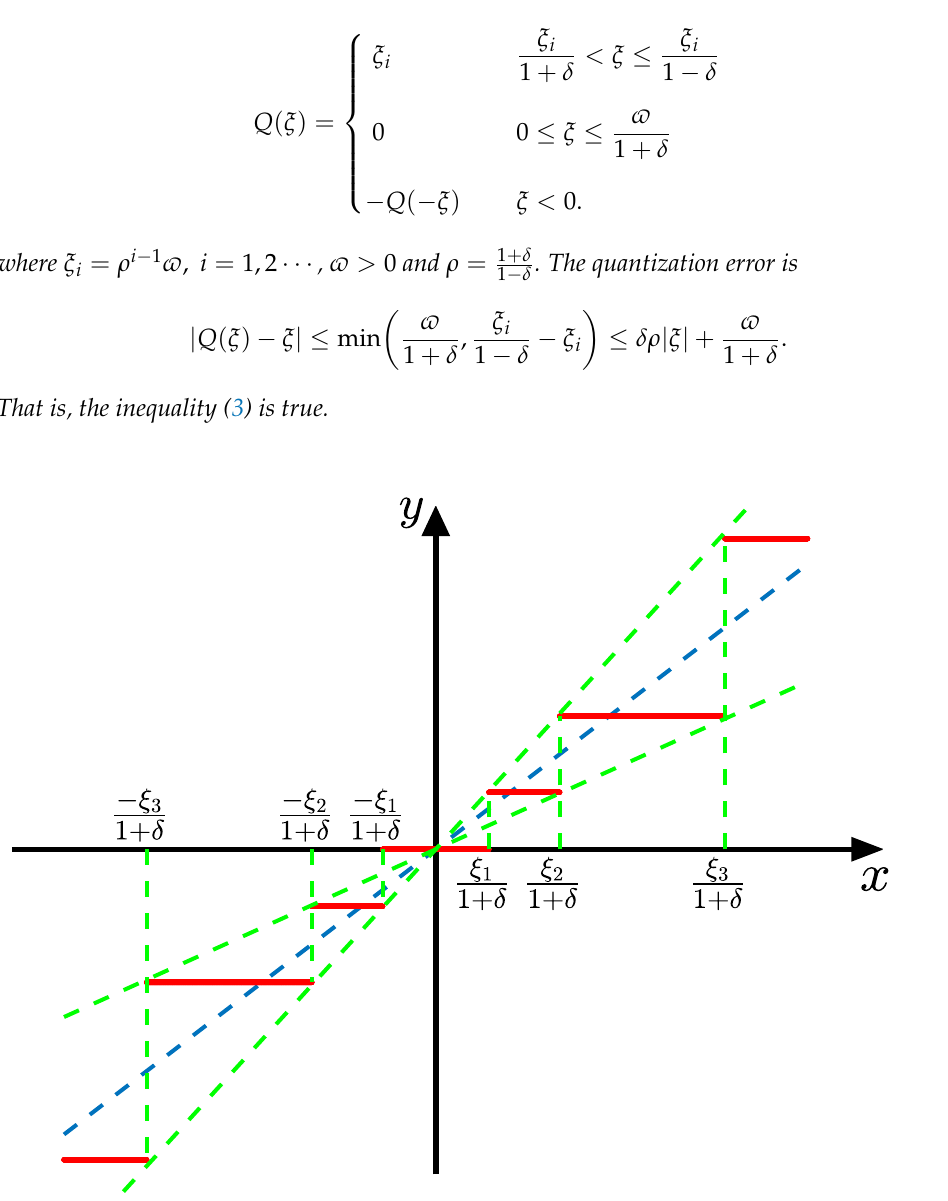
Figure 3. Diagram of the logarithmic